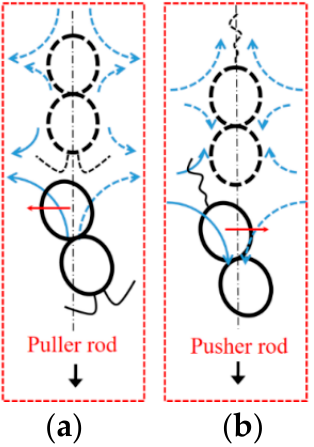
Figure 9. Mechanism of the rotation tendency of a pusher and a puller at a finite Re s : ( a ) puller; ( b ) pusher ( s = d , i = 2). The black dotted line and the solid line represent the squirmer at the previous time and the current time, respectively. The blue arrow indicates the flow generated by the squirmer at the previous time, and the solid arrow indicates the influence of the flow at the previous time on the squirmer’s motion at the current time. The red arrow indicates the influence of the direction of the flow on the deflected squirmer.